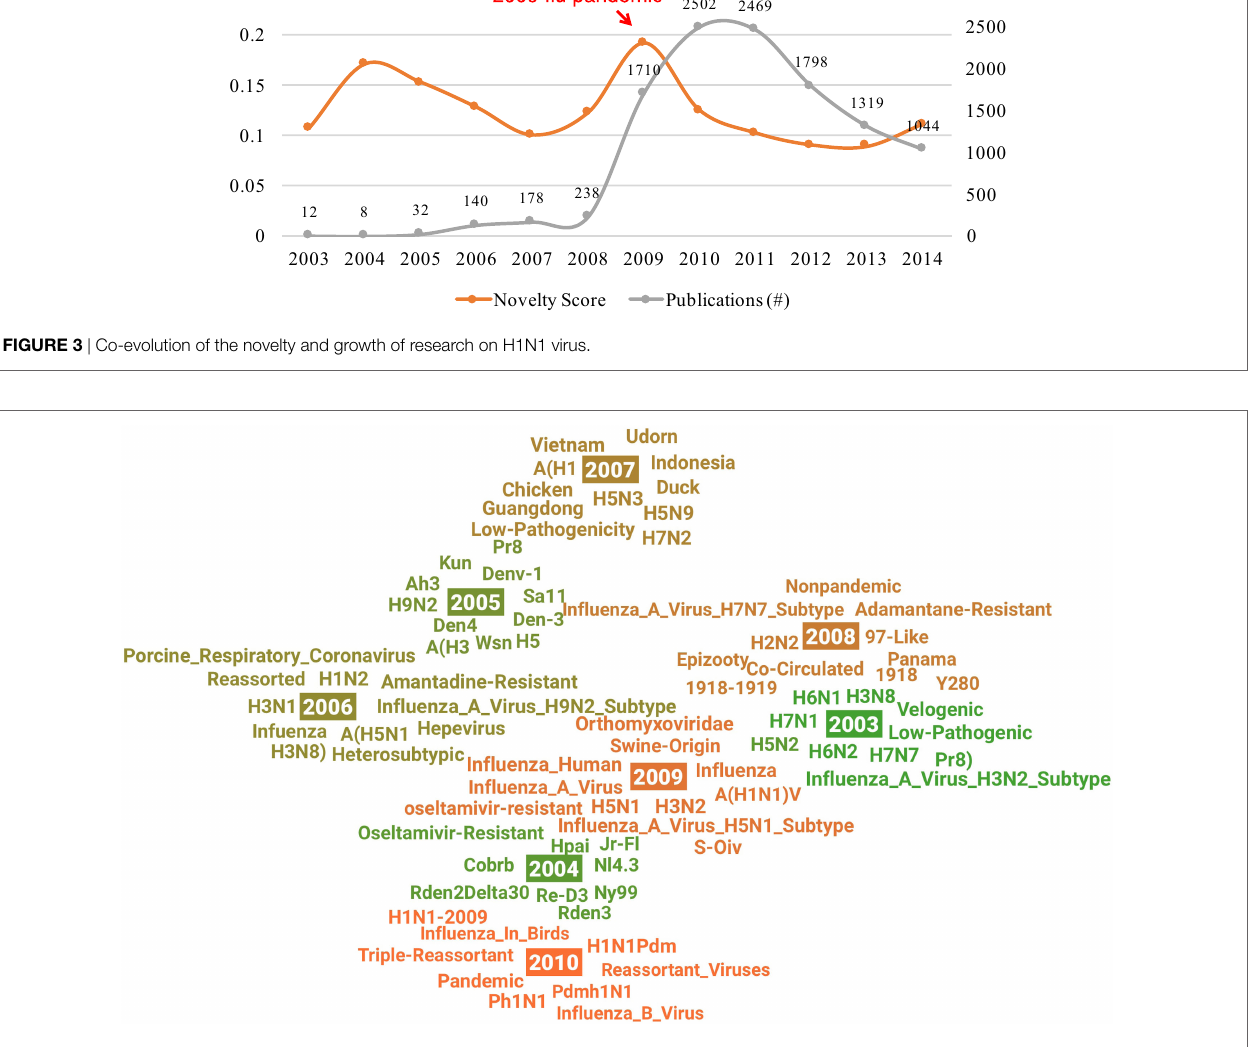
FIGURE 4 | Visualization of the semantic change in research on “H1N1 Virus” from 2003 (green) to 2010